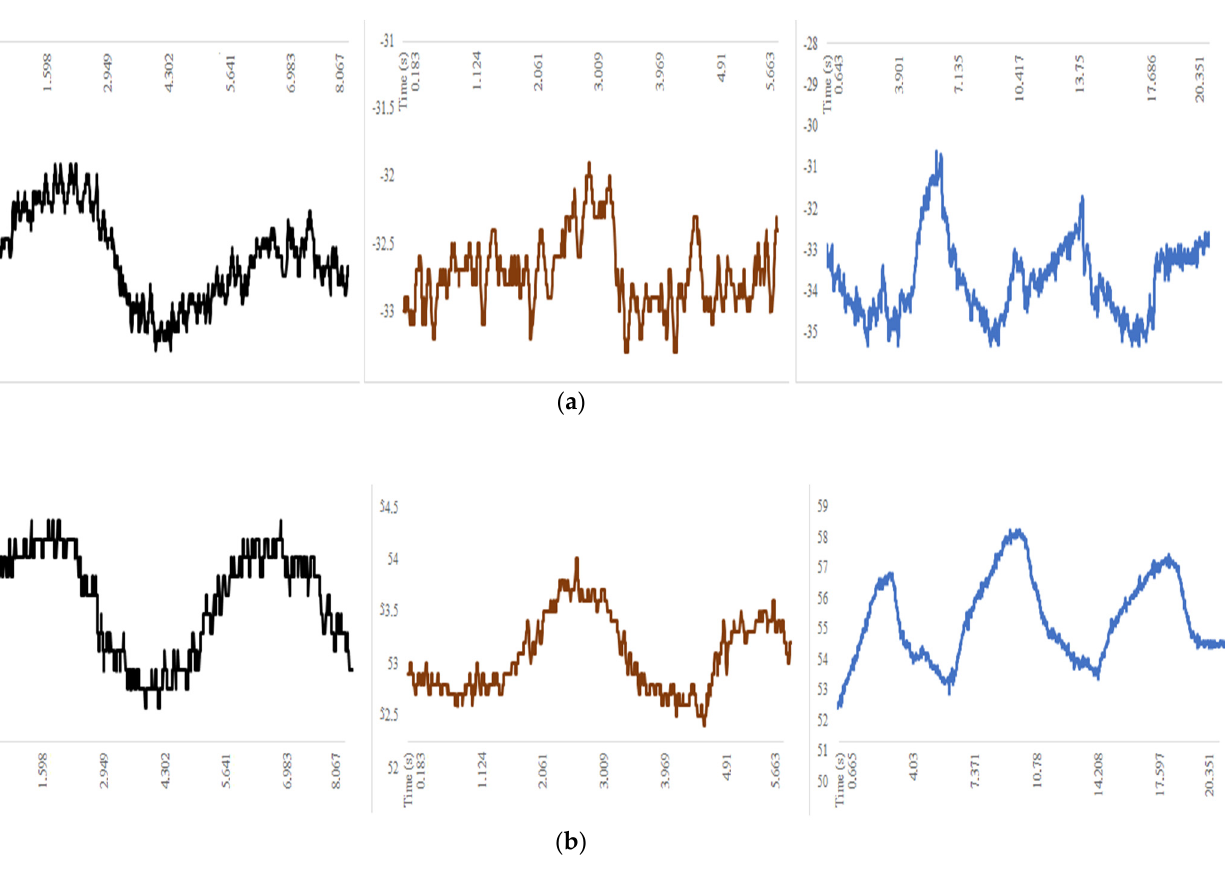
Figure 6. Acquired data by SENSIRIB on the sixth rib on a volunteer for a test in terms of: ( a ) roll angle; ( b ) pitch angle (in black for the pre-operative condition, in red for the post-operative condition on the operated side, in blue for the post-operative condition on the non-operated side).